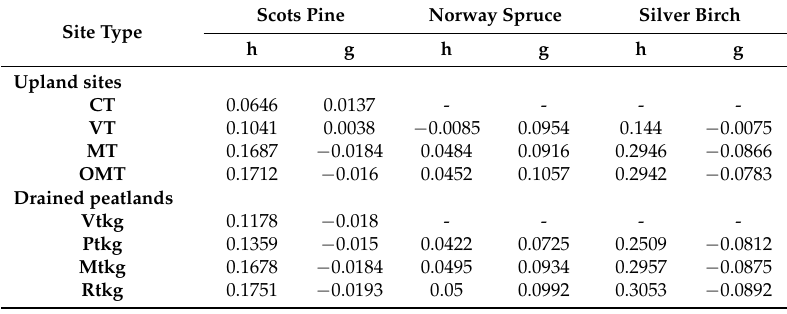
Table A2. Parameters used in Equation (4) for climate change (cc) scenarios on poor (dry heath, Calluna type, CT), quite poor (dryish heath, Vaccinium type, VT), medium (fresh heath, Myrtillus type, MT), and rich (grove-like heath, Oxalis-Myrtillus type, OMaT) upland sites.